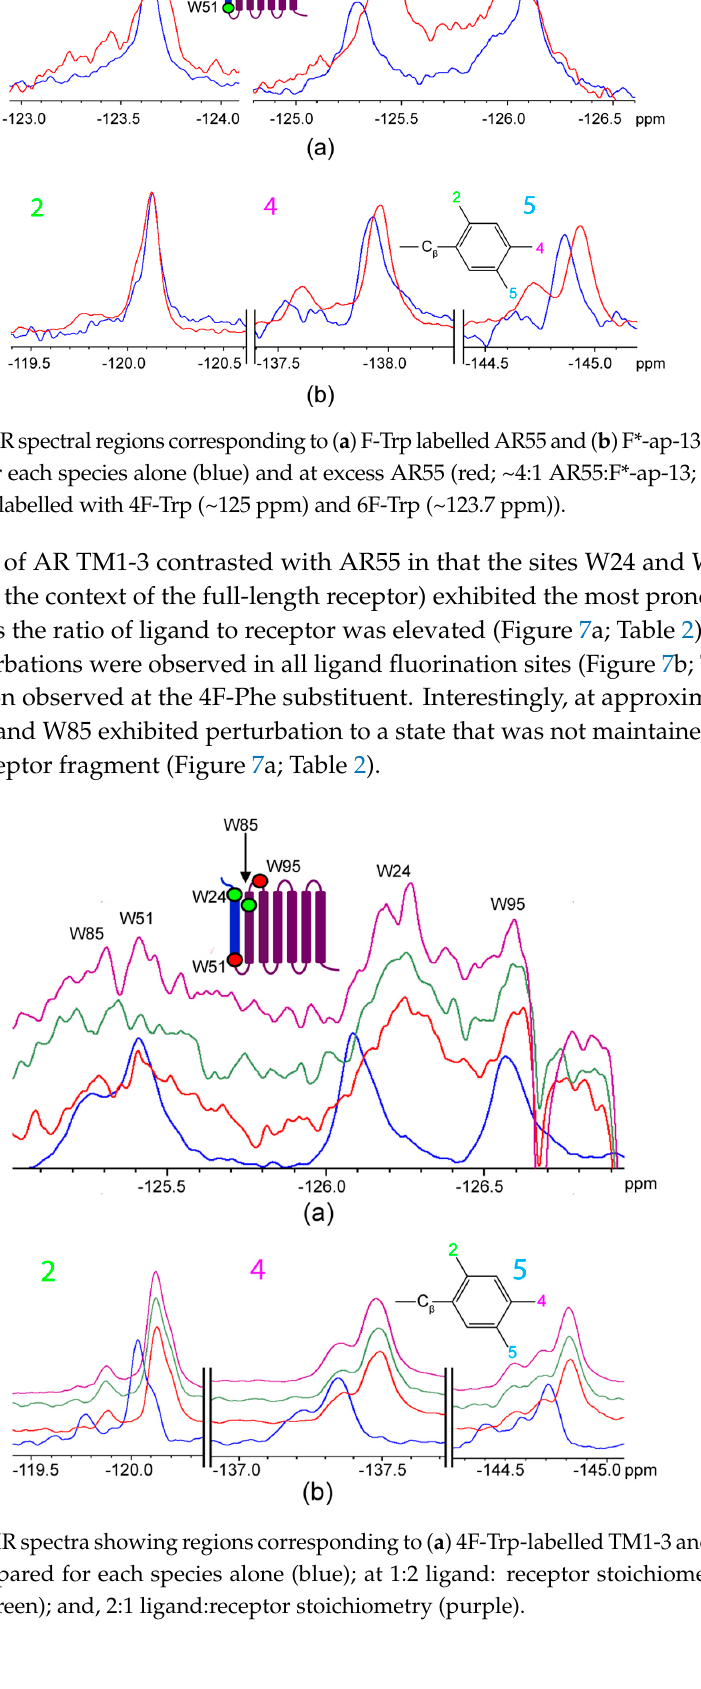
Figure 7. 19 F NMR spectra showing regions corresponding to ( a ) 4F-Trp-labelled TM1-3 and ( b ) F*-ap-13. Spectra are compared for each species alone (blue); at 1:2 ligand: receptor stoichiometry (red); 1:1 stoichiometry (green); and, 2:1 ligand:receptor stoichiometry (purple).